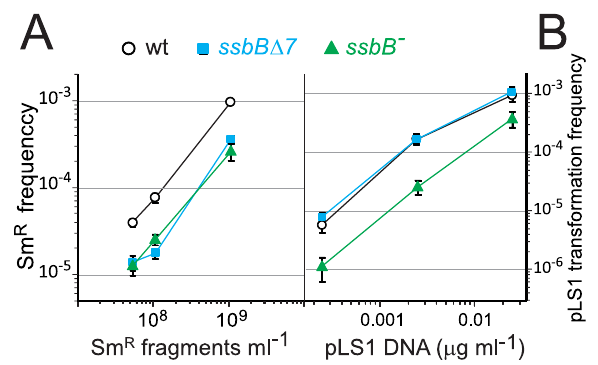
Figure 4. Differential effect of ssbB 2 and ssbB D 7 mutations on chromosomal and plasmid chromosomal transformation. (A) Competent cells ( , 1.5 10 8 cfu ml 2 1 ) of strain R1818 ( ssbB + ), R2647 ( ssbB D 7 ) and R2646 ( ssbB 2 ) were exposed to subsaturating concentrations (0.05 to 1 ng ml 2 1 ) of an 888-bp rpsL41 fragment. Sm R transformants were scored. (B) Transformation with subsaturating concentrations of pLS1 plasmid DNA (0.00025 to 0.025 m g ml 2 1 ) using the same competent cells as in panel A. Tc R transformants were